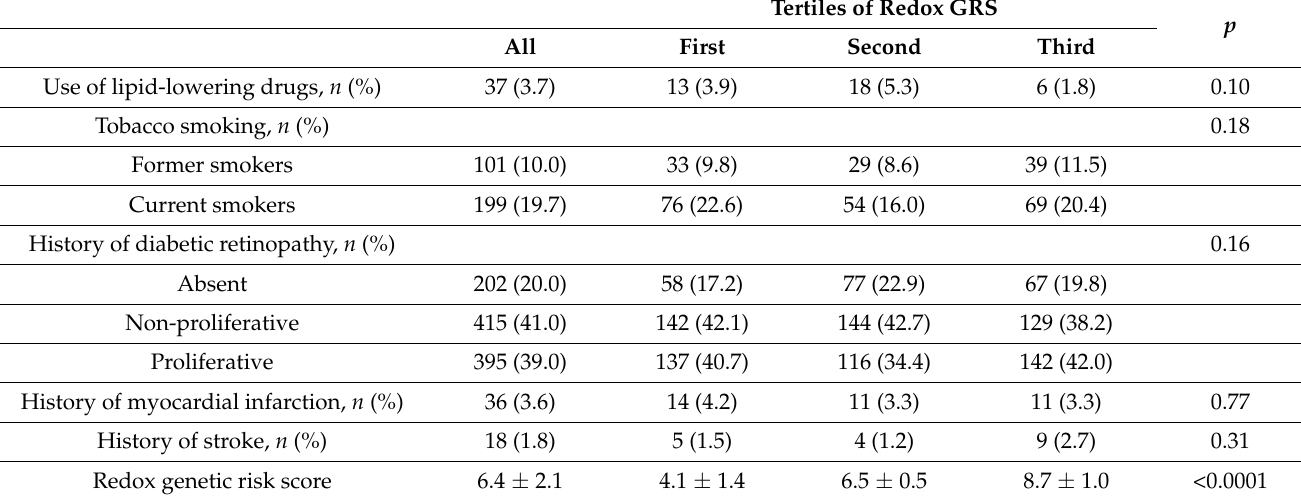
Tertiles of Redox